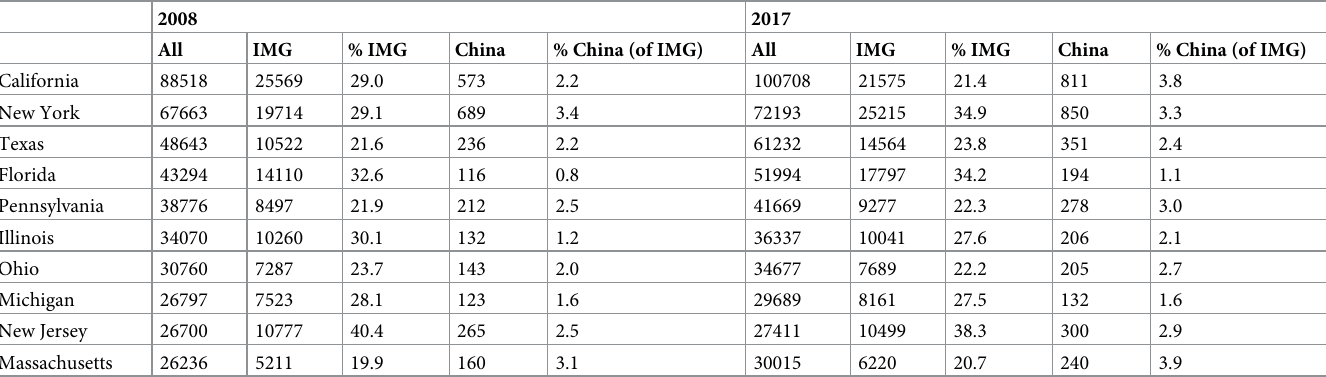
Table 3. Location of practice for